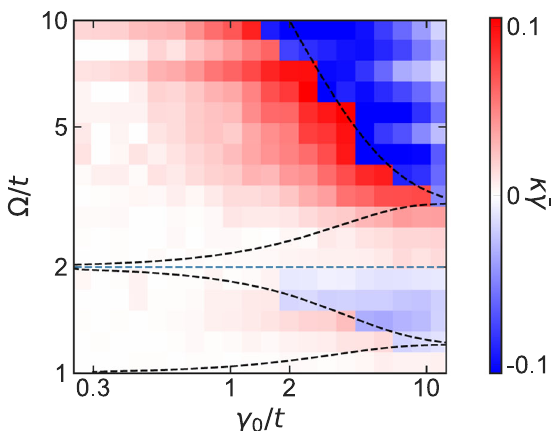
Fig. 4 Phase diagram for quantum anti-Zeno to Zeno transition from experimental data. Color contour is the measured κγ (see main text for de fi nition). The black dashed lines indicate the exceptional points [see Fig. 1(c)], and the blue dashed line corresponds to the critical kick frequency Ω 1 ¼ 2 t . The blue (red) regions correspond to quantum Zeno (anti-Zeno) regimes. All γ are measured after the system evolves for two modulation periods, while we set t ¼ 2 π ´ 1 : 03 ð 2 Þ kHz and τ 0 t = ð 2 π Þ ¼ 0 : 1 for all measurements. The measured critical anti-Zeno to Zeno transition points are consistent with the exceptional points between the M j and L j